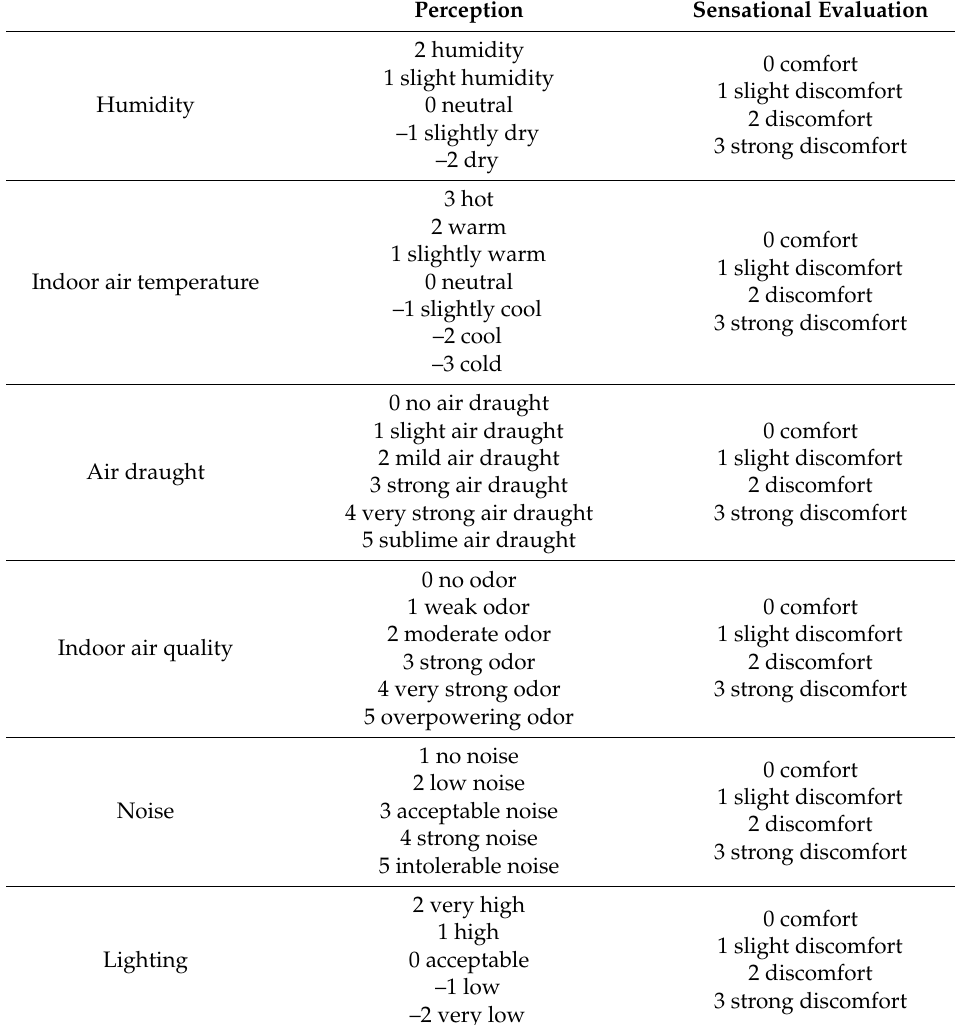
Table 1. Scales used for the subjective